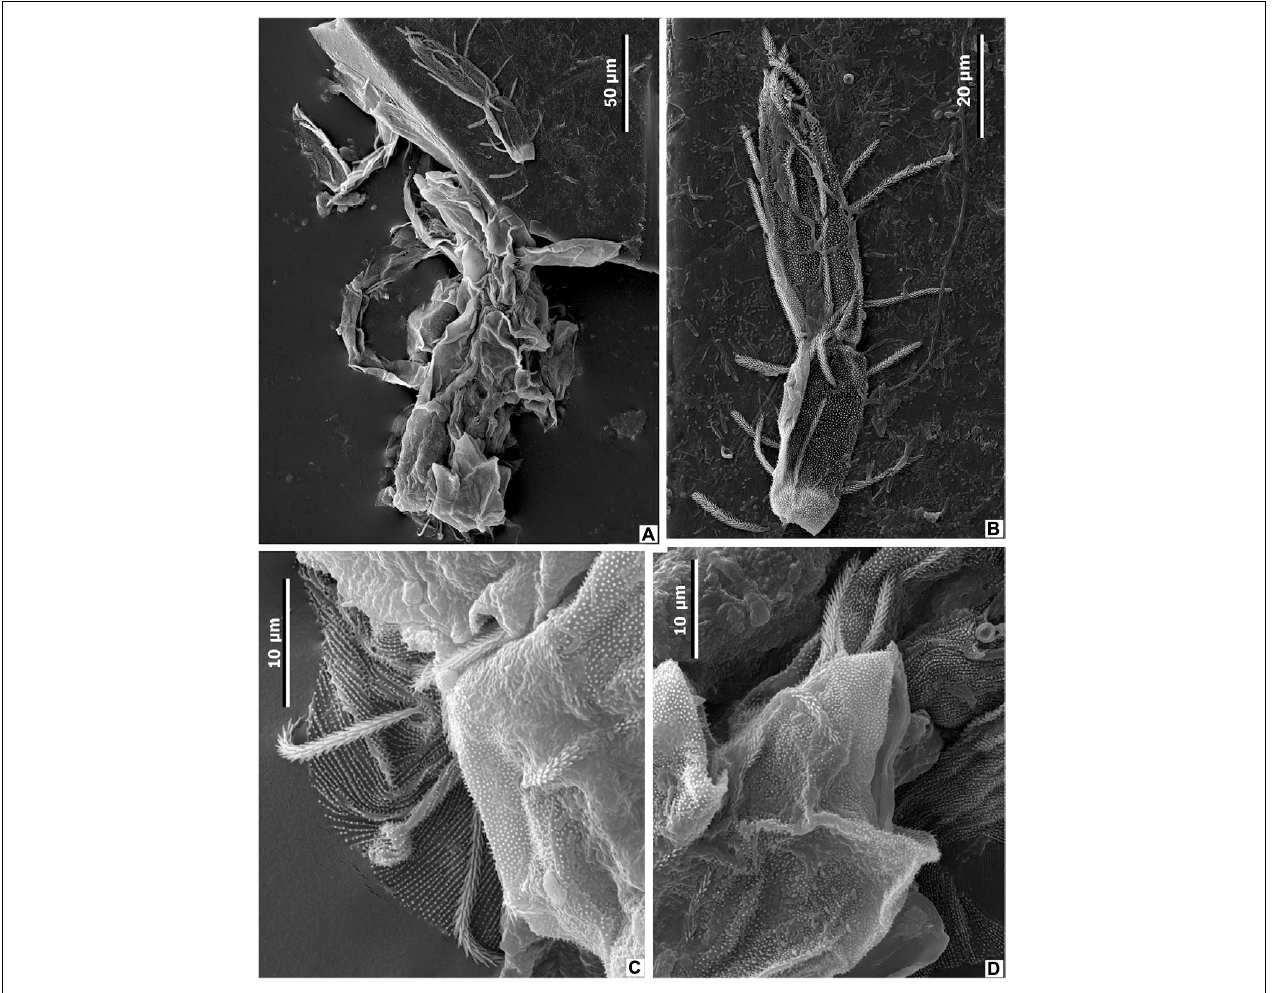
FIGURE 15 | Mite from the leaf domatia of M. eosinica sp. nov., MMJ3-837-3a, SEM. (A) Incomplete mite exoskeleton, general view. (B) Mite leg. (C,D) Details of mite